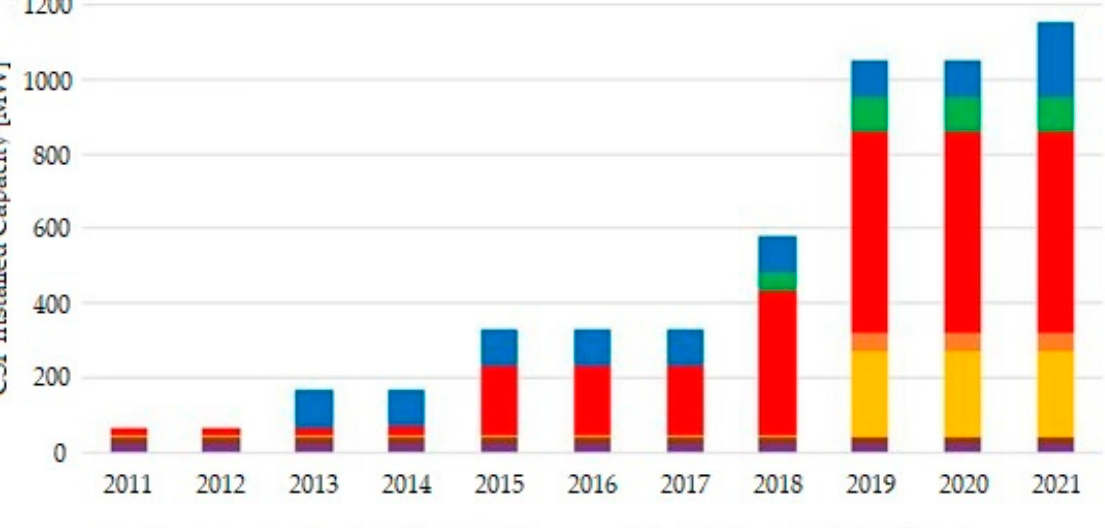
Figure 1. CSP capacity installed in the MENA region. Source: own elaboration based on [3].